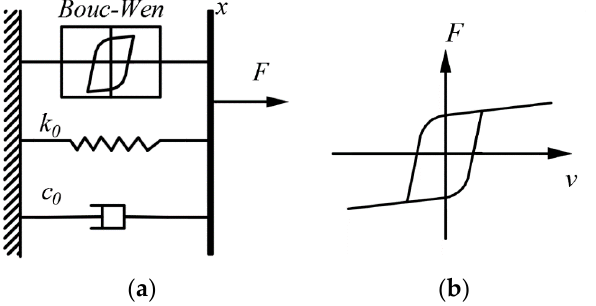
Figure 5. Damping characteristics test of the MRF damper: ( a ) Bouc-Wen model structure; ( b ) the relationship between the damping force, F , and relative velocity, v , of the MRF damper.